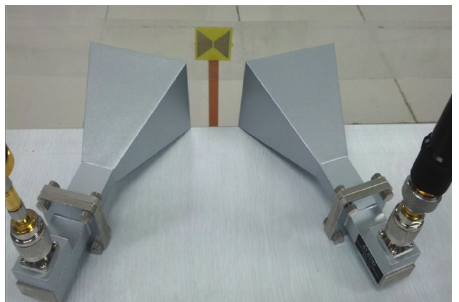
Figure 8: Measurement setup using bistatic configuration.